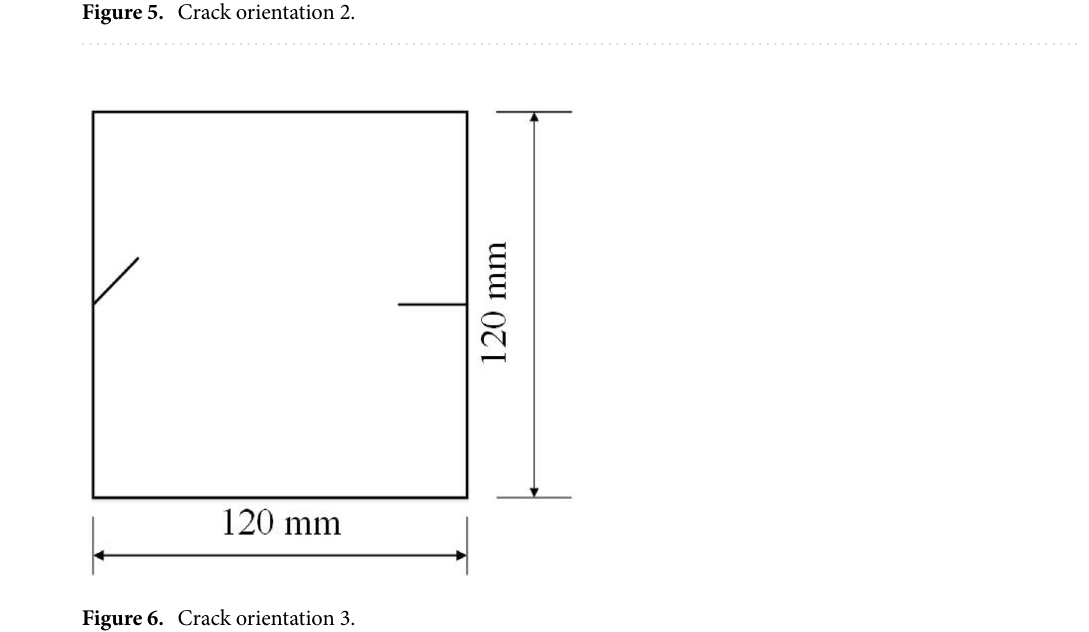
Figure 6. Crack orientation 3.